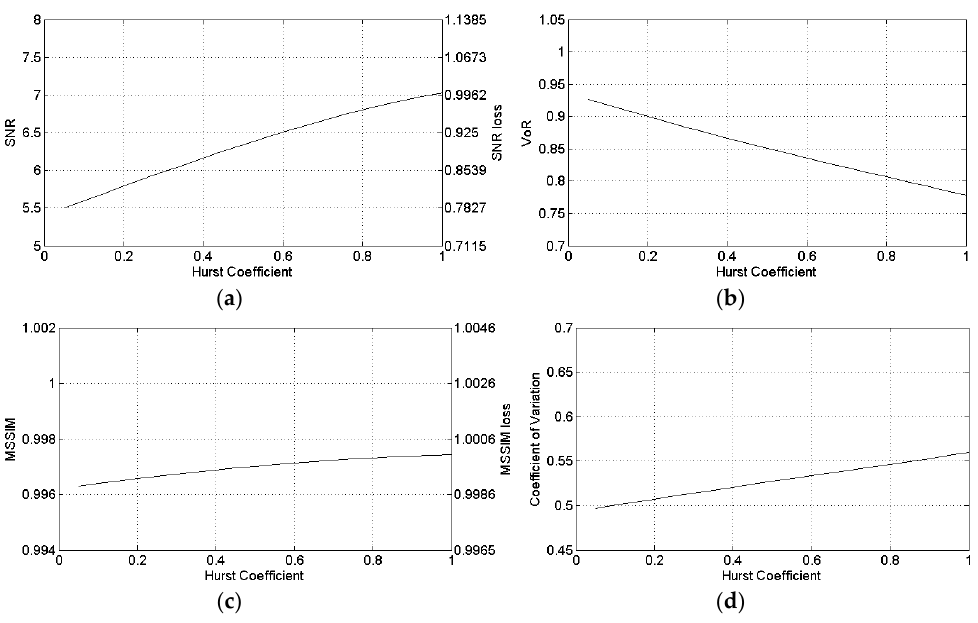
Figure 6 . Sensitivity of SB-SARBM3D against the Hurst coefficient: ( a ) SNR; ( b ) VoR; ( c ) MSSIM; ( d ) coefficient of variation.